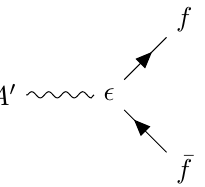
Figure 2. Feynman diagrams for the cascade annihilation of dark matter into on-shell dark photons (left) and subsequent decay of dark photons to SM fermions